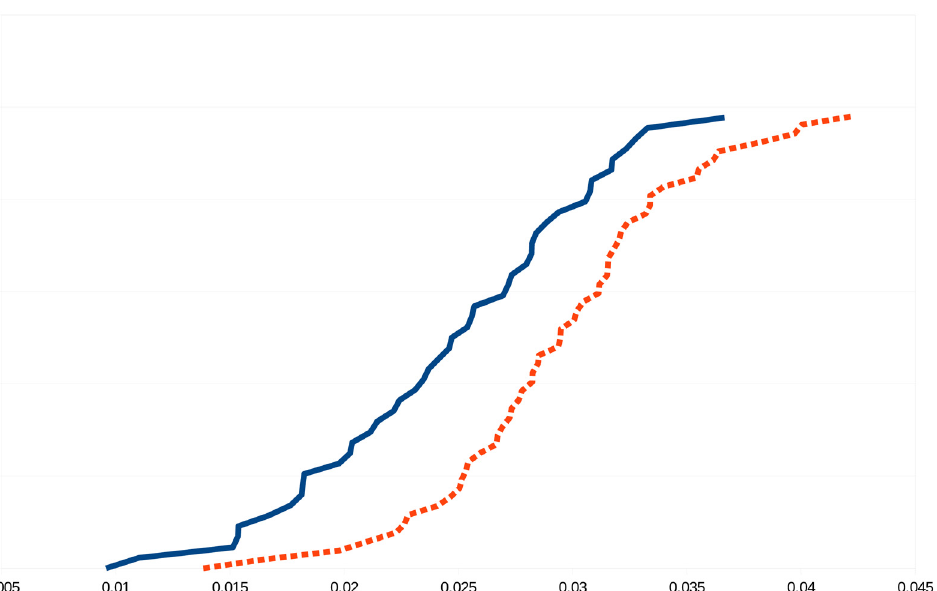
Fig 4. Empirical cumulative distribution function of the All_PGEigengap_FiberNDivLength graph parameter (that is, the eigengap of the transition- matrix of the whole brain graph with each edge weighted by the number of fibers belonging to the edge, divided by their average length), in the 129-node resolution. For every value x on the horizontal line, the curves demonstrate the male (blue, continuous line) and female (red, dashed line) fraction of subjects with All_PGEigengap_FiberNDivLength value of at most x . For example, for x = 0.025, about 17% of the females have the All_PGEigengap_FiberNDivLength value less than x , while about 58% of males have that value less than x .